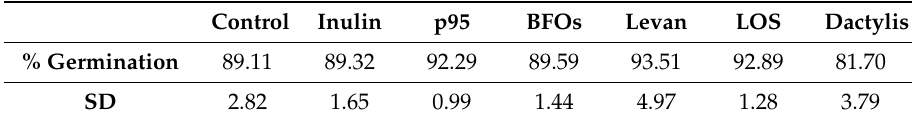
Table 1. Germination e ffi ciency of B. cinerea spores in response to di ff erent fructans. Germination e ffi ciency (%) of B. cinerea spores 24 h after transfer to 24 g / L potato dextrose agar (PDA) plates supplemented with 5 g / L fructan, or control plates containing PDA only. At least 120 spores from three independent plates were considered for each